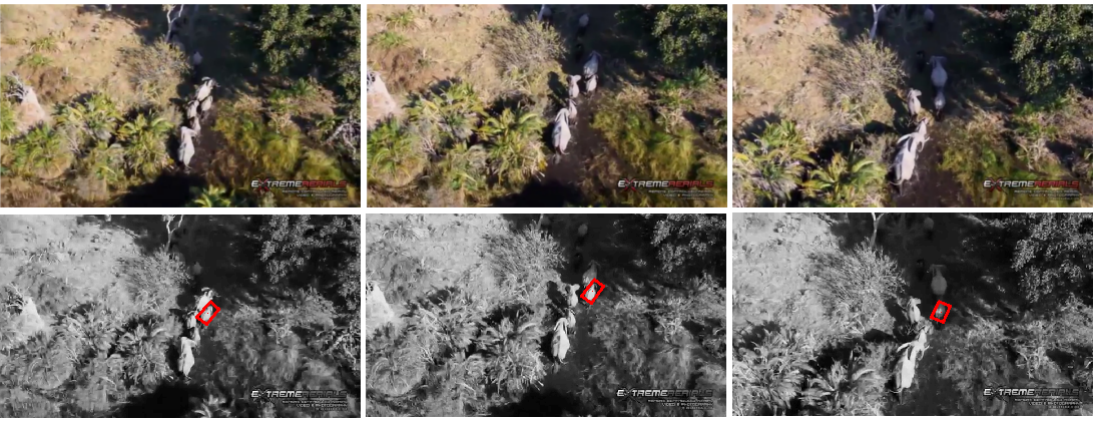
Figure 8. Visual elephant